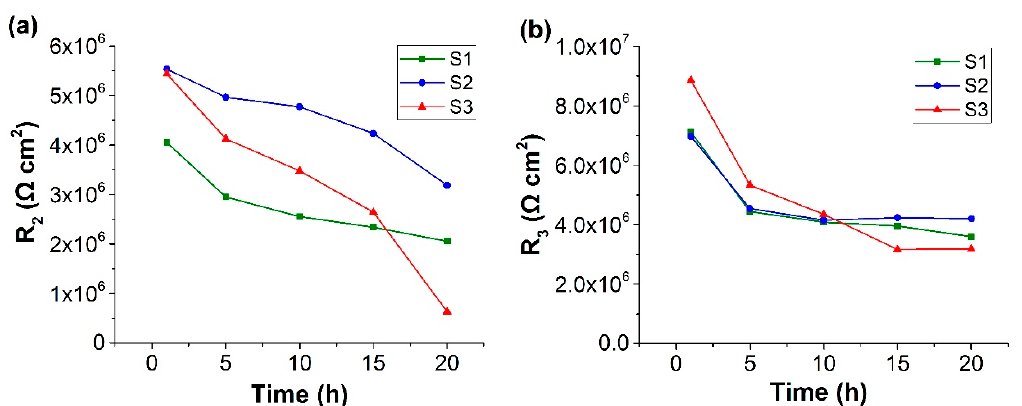
Figure 7. Evolution of fitting parameters for S1, S2 & S3 using the equivalent circuits in Figure 5 following 20 h immersion in 0.1 wt.% NaCl Solutions. ( a ) Coating resistance, R 2 and ( b ) intermediate layer resistance R 3 .